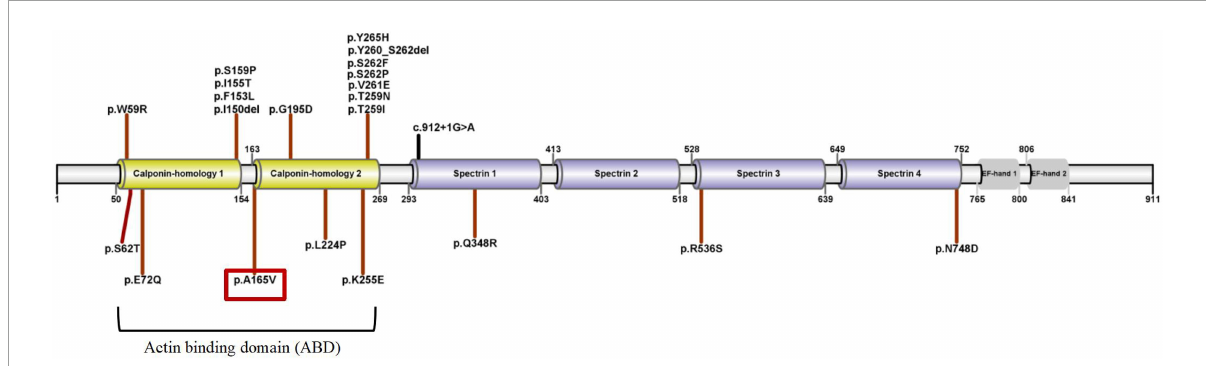
FIGURE4 The schematic diagram of ACTN4 variants and ACTN4 protein’s domains (UniProtKB-O43707). The patient’s ACTN4 variant was marked with a red box.